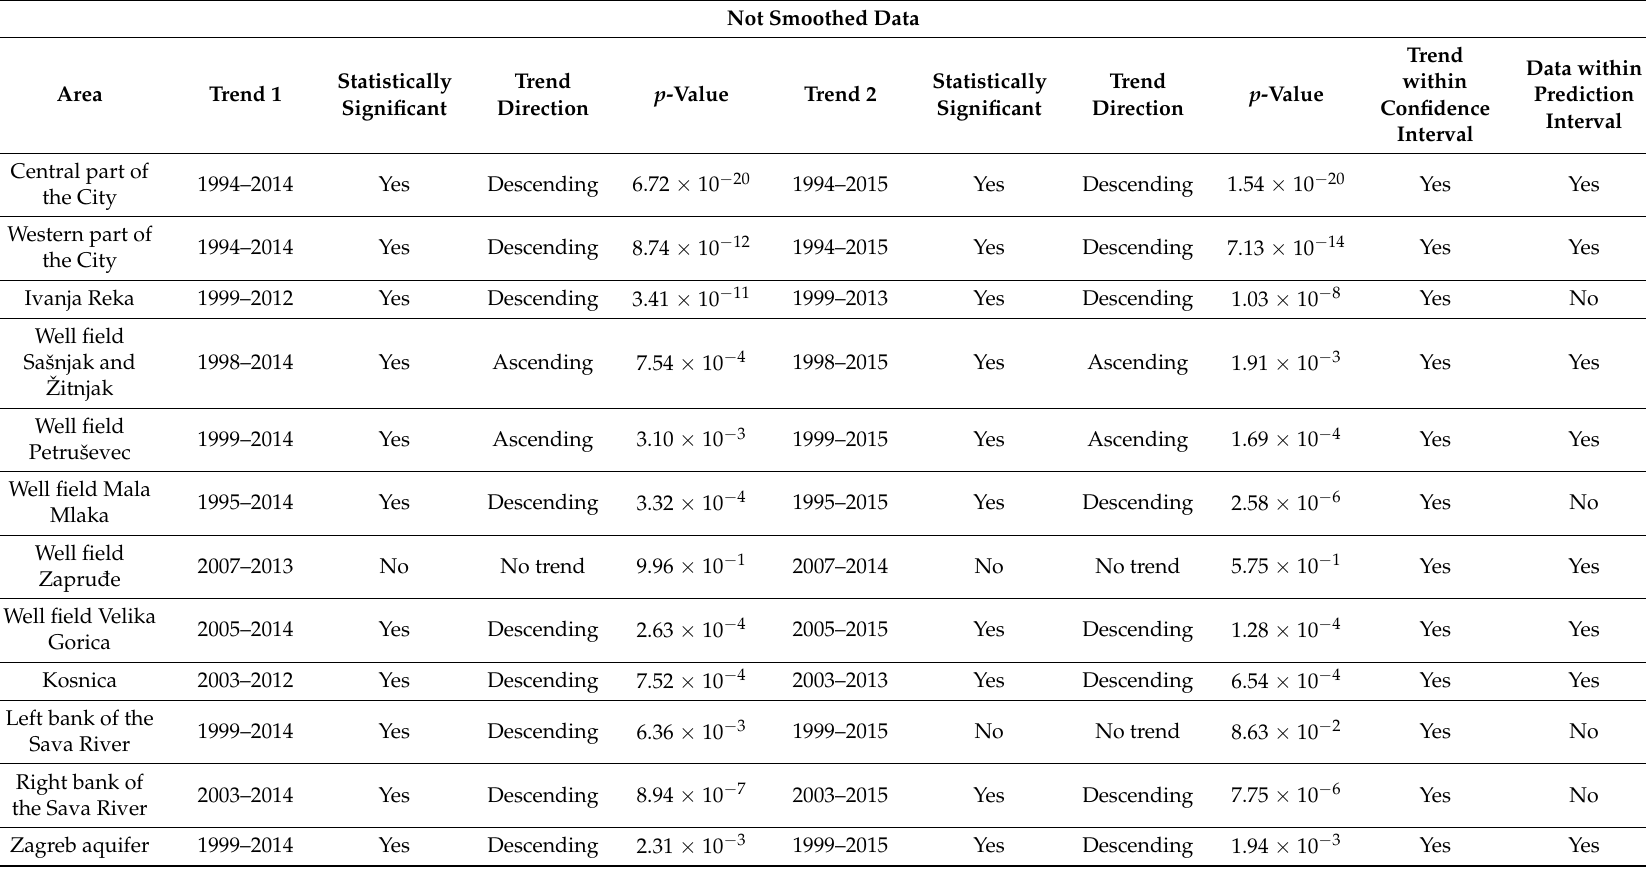
Table 3. Summary results of nitrate trend’s estimation at different observational scales (not smoothed